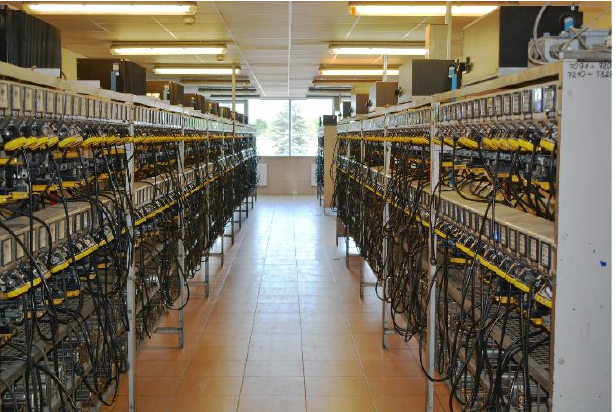
Figure 3. A chain bath in LW Bogdanka S.A. Source: photo provided by LWB. In turn, the place where workers meet (both before and after the descent) is the lamp room (Figure 4). From this place, underground mine workers retrieve the necessary equipment for the task, i.e., escape apparatus, oxygen detectors, front mining lamps and personal protective equipment, among others. The number of people picking up and putting down equipment at the same time, as well as the narrow aisles between lamp loading stations or escape apparatus shelves, make the lamp room an impossible place to maintain a 1.5 m distance. This is related to an infrastructure that does not allow for the reorganisation of stations (the lamps are at a very short distance from each other) and the workers tend to be close to each other.